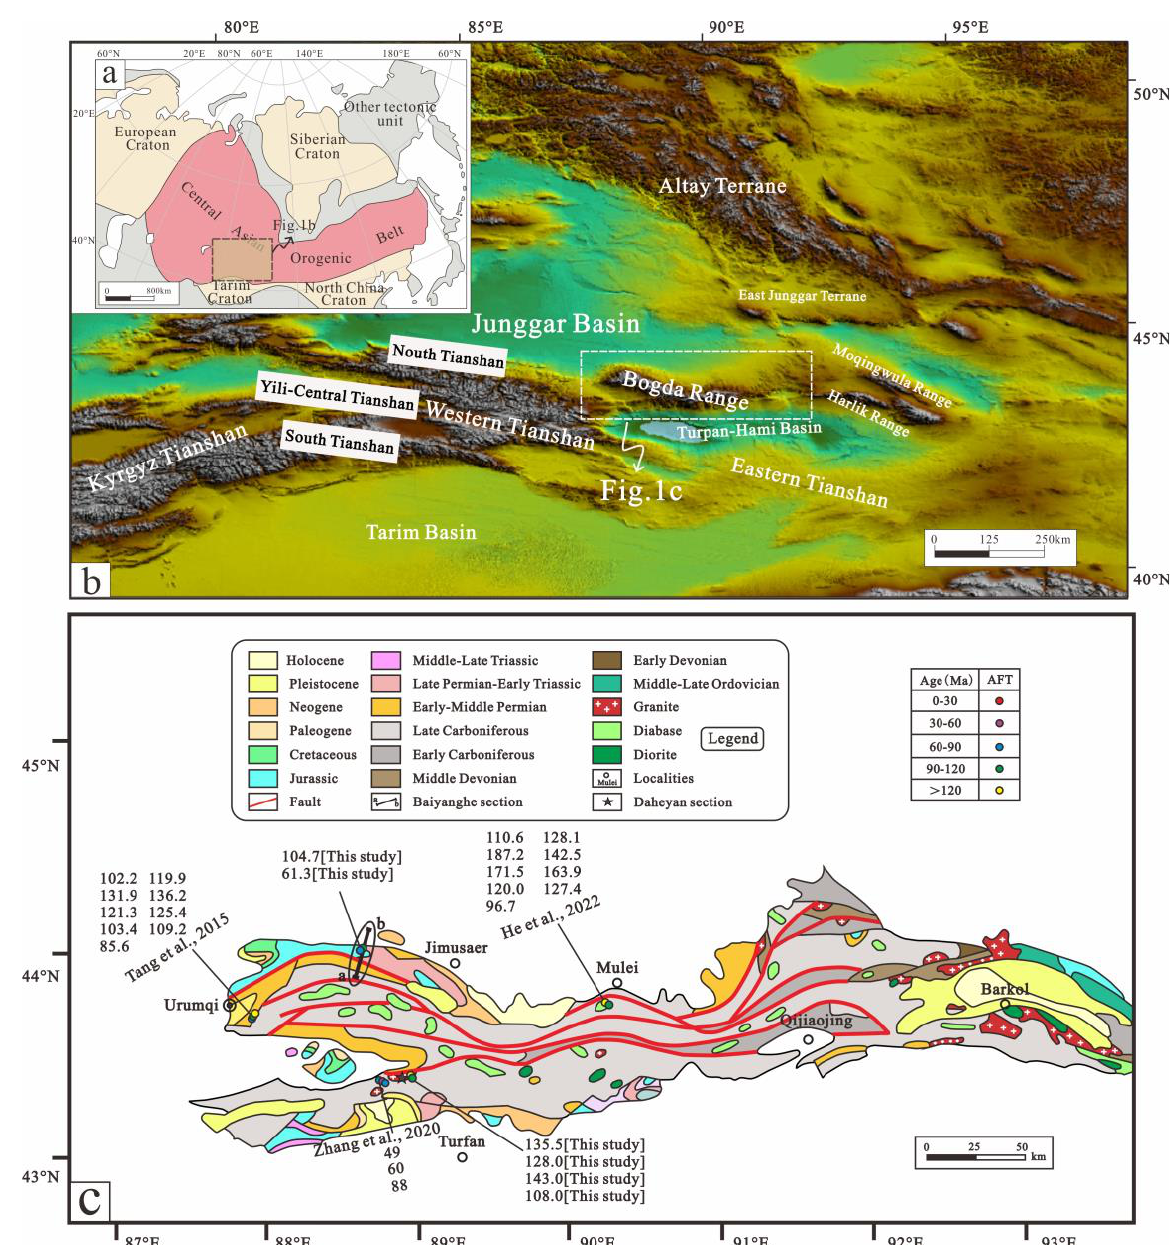
Figure 1. ( a ) Simplified tectonic map showing the position of the Central Asian Orogenic Belt (CAOB) and the Tianshan area (modified from [24]). ( b ) Topographic map of Chinese Tianshan-Junngar-Altai (modified from [25]). ( c ) Geological map of the Bogda, with Mesozoic apatite fission track ages (modified from [26]). The black star and a – b line are the sampling profile locations.